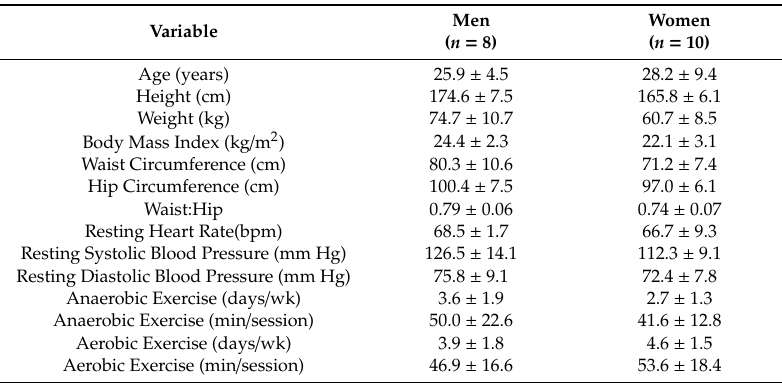
Table 1. Characteristics of healthy men and